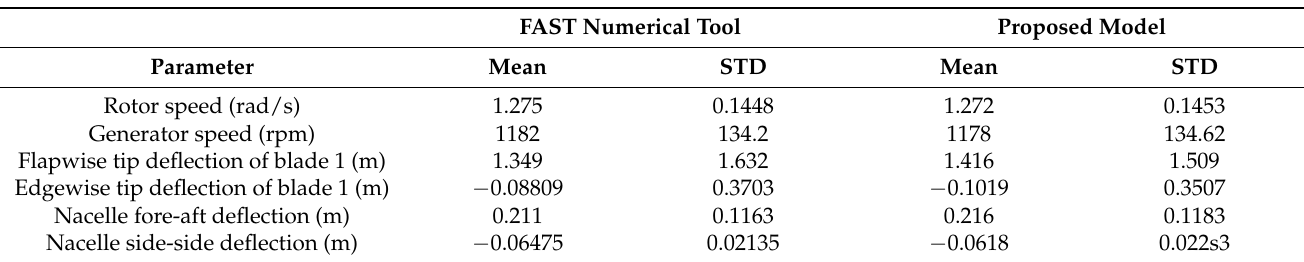
Table 2. Comparison with the performance of the aeroelastic model in this research with FAST. Mean wind speed 18 m/s and turbulence intensity 10% (region